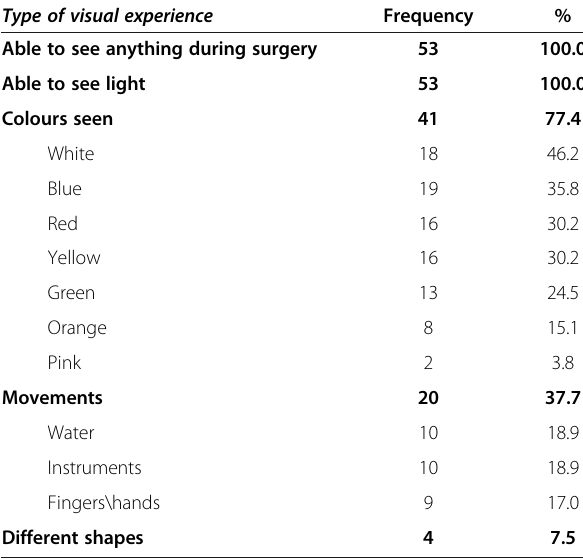
Table 2 Visual sensations experienced by patients (n = 53) during cataract surgery under topical